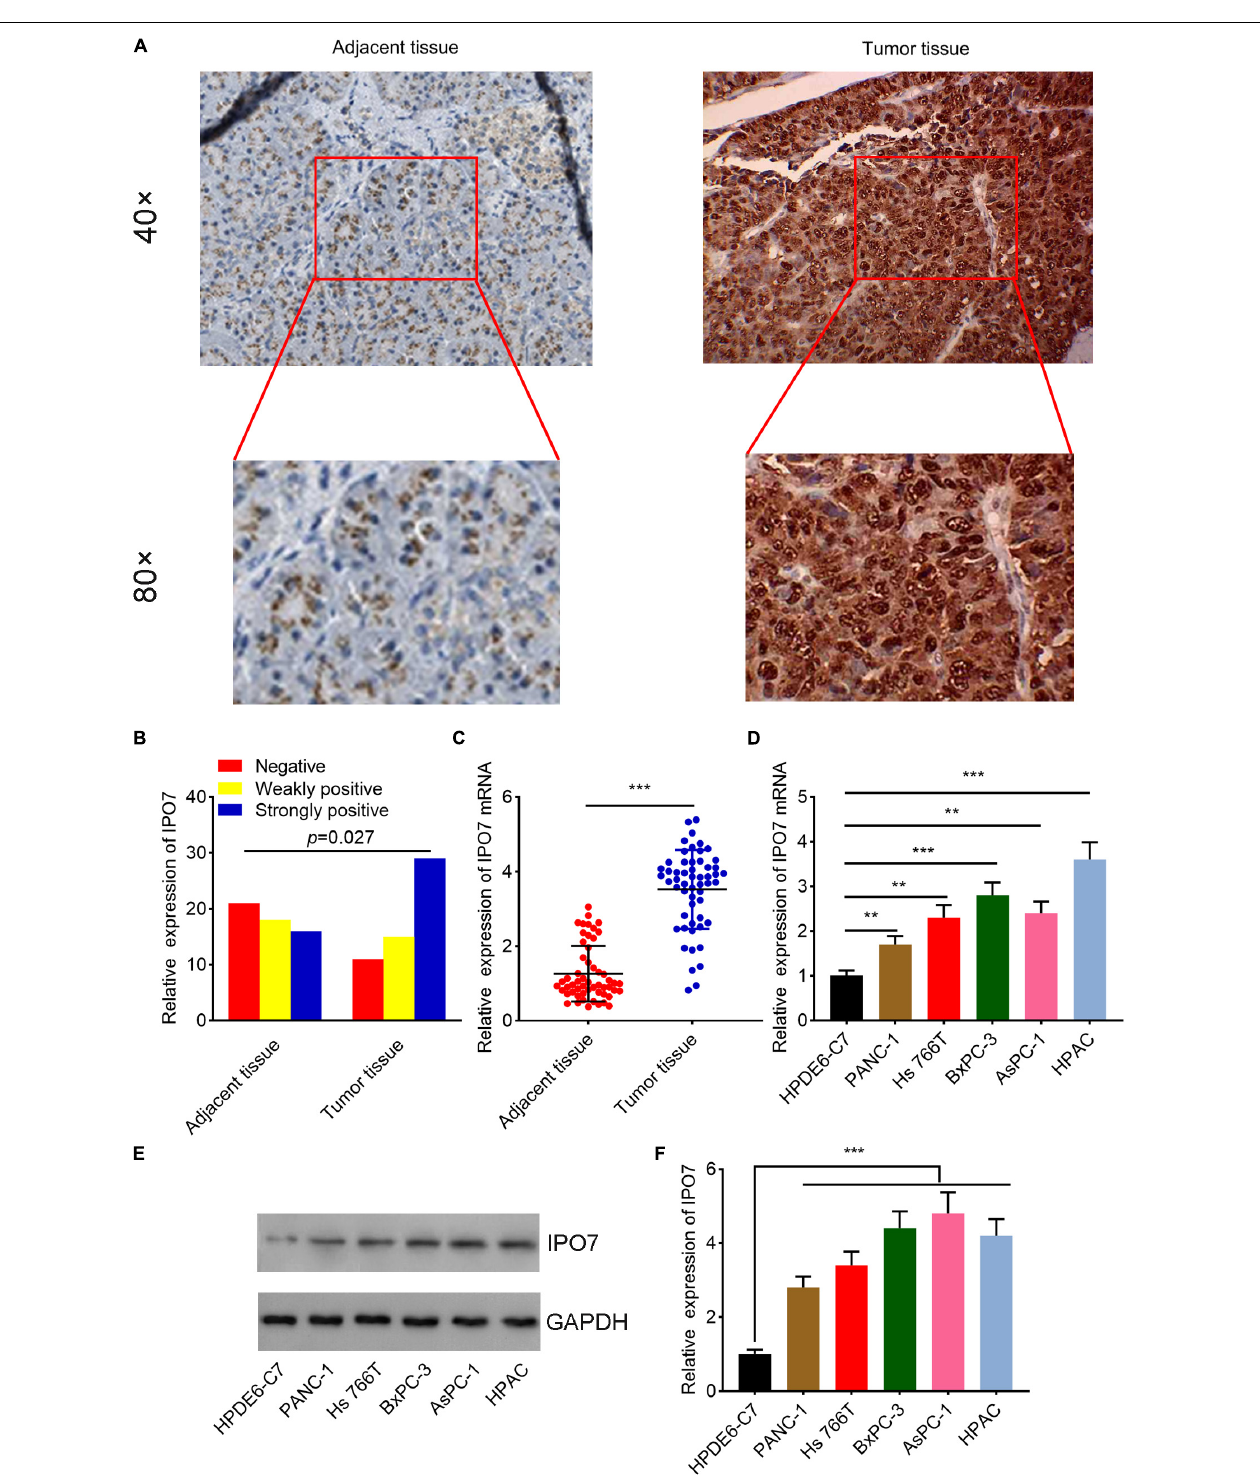
FIGURE 2 | Importin 7 (IPO7) is upregulated in pancreatic cancer tissue and cells. (A) Representative immunohistochemical images of pancreatic cancer tissues and adjacent tissues. (B) The strong positive rate, weak positive rate, and negative rate of IPO7 expression in 55 pairs of pancreatic cancer and adjacent tissues were compared. (C) qPCR was performed to evaluate the expression of IPO7 mRNA in pancreatic cancer tissues and adjacent tissues. (D–F) qPCR (D) and Western blot (E,F) were performed to determine the expression of IPO7 in normal human pancreatic duct epithelial cells (HPDE6-C7) and five different human pancreatic cancer cell lines (PANC-1, HS_766T, BxPC-3, AsPC-1, and HPAC) at the mRNA level and protein level. ** p < 0.01, *** p < 0.001.